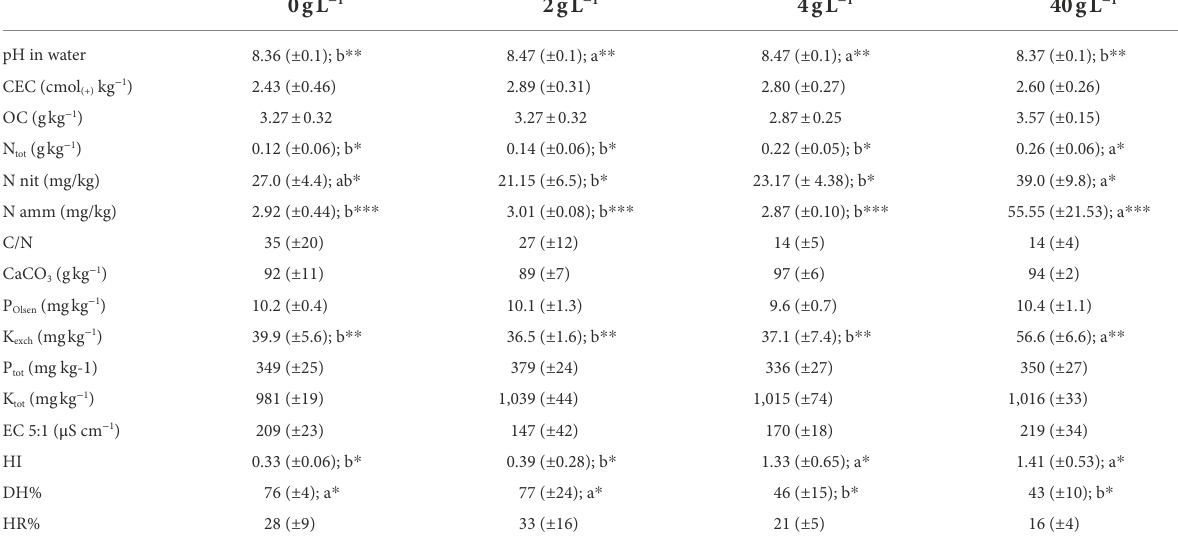
TABLE 1 Physicochemical characterization of the treated soils and the